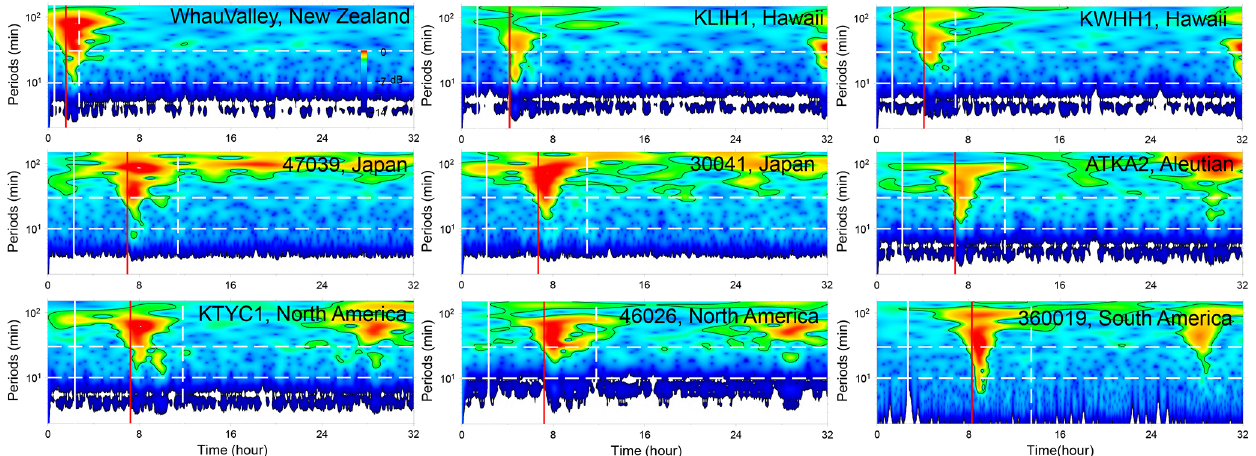
Figure 8. Wavelet analysis of some representative barometers. In each subplot, the solid vertical white lines mark the arrival time with travelling velocity of 1000ms − 1 . The solid vertical red lines mark the arrivals of Lamb waves. The dashed vertical white lines mark the lower limit of AGWs’ velocity of 200ms − 1 . The dashed horizontal white lines mark three reference periods of 10 and